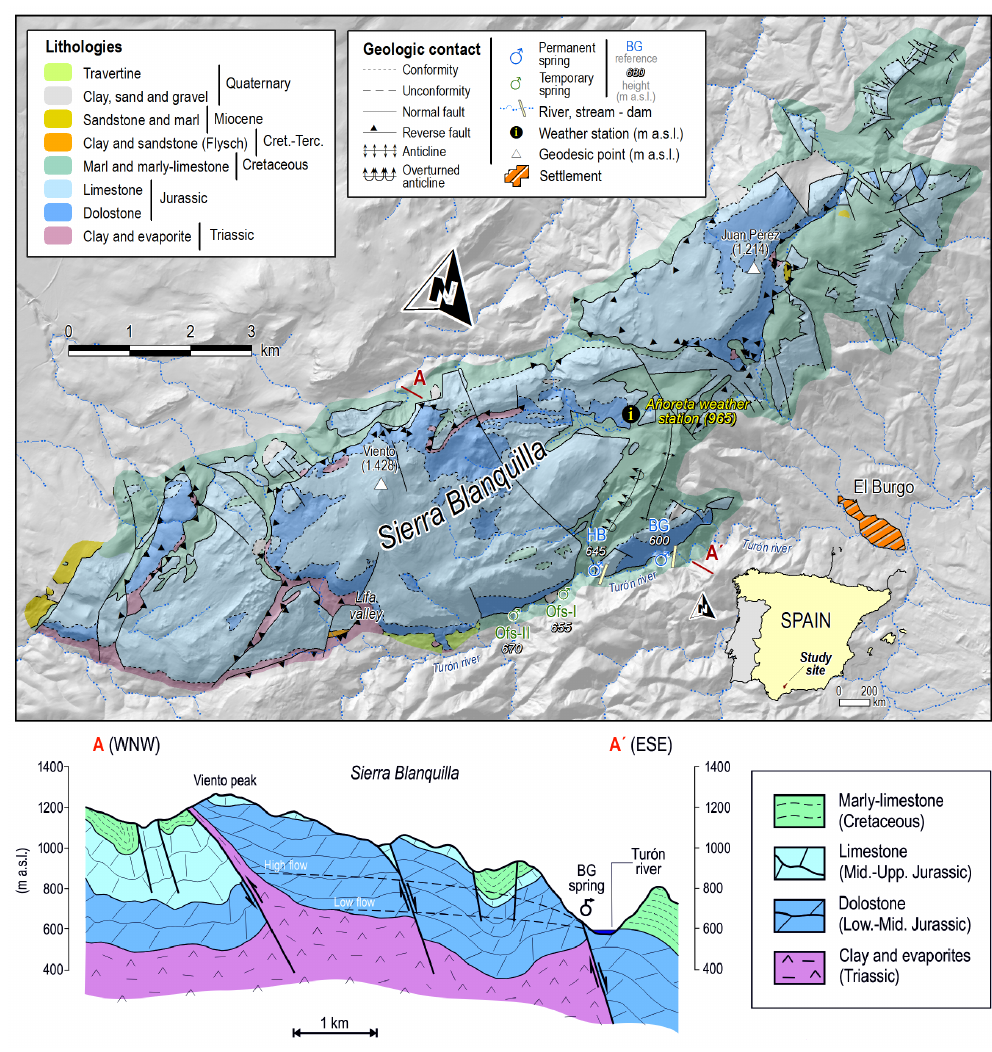
Figure 1. Geographic, geological, and hydrogeological features of the Sierra Blanquilla carbonate